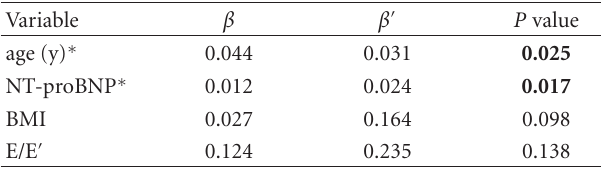
Table 6: Multivariable linear regression for Log hs-CRP as depen- dent